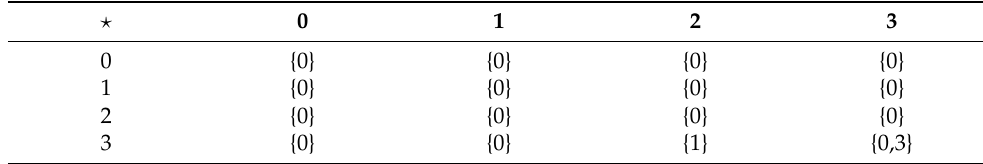
Table 2. The binary hyperoperation (cid:63) on C .